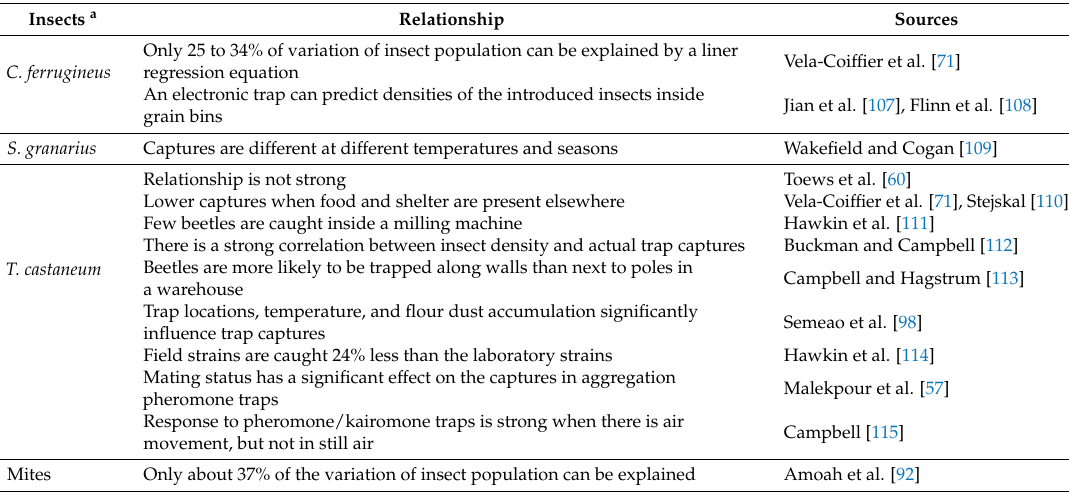
Table 3. Relationship between trap capture and actual population